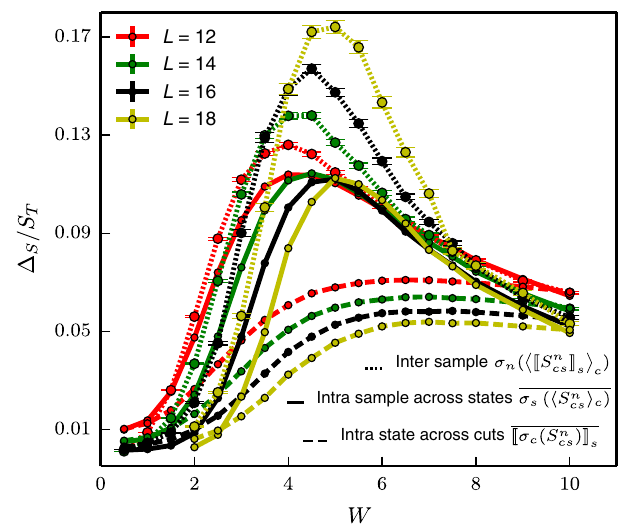
FIG. 5. Standard deviation of the half-chain entanglement entropy Δ S divided by the random pure state value S T , parsed by its contributions from cut-to-cut (dashed lines), eigenstate-to- eigenstate (solid lines), and sample-to-sample (dotted lines)